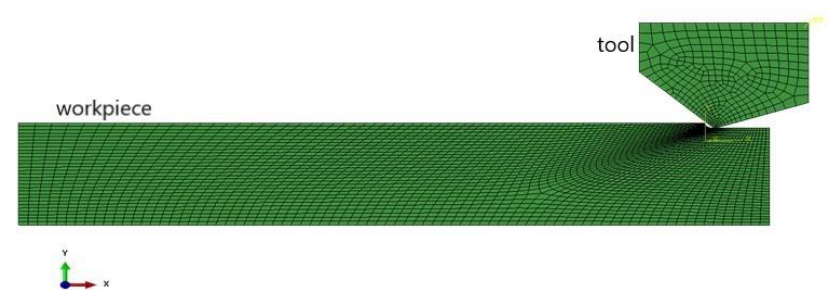
Figure 2. KDP crystal cutting process finite element simulation